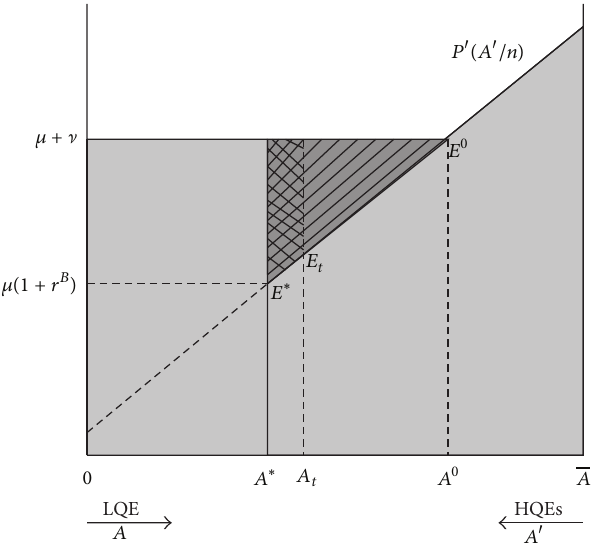
Figure 3: LQE and HQE market